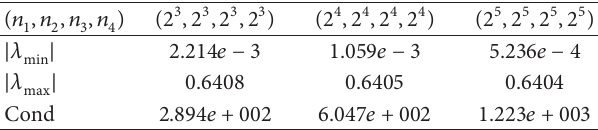
Table 2: The condition